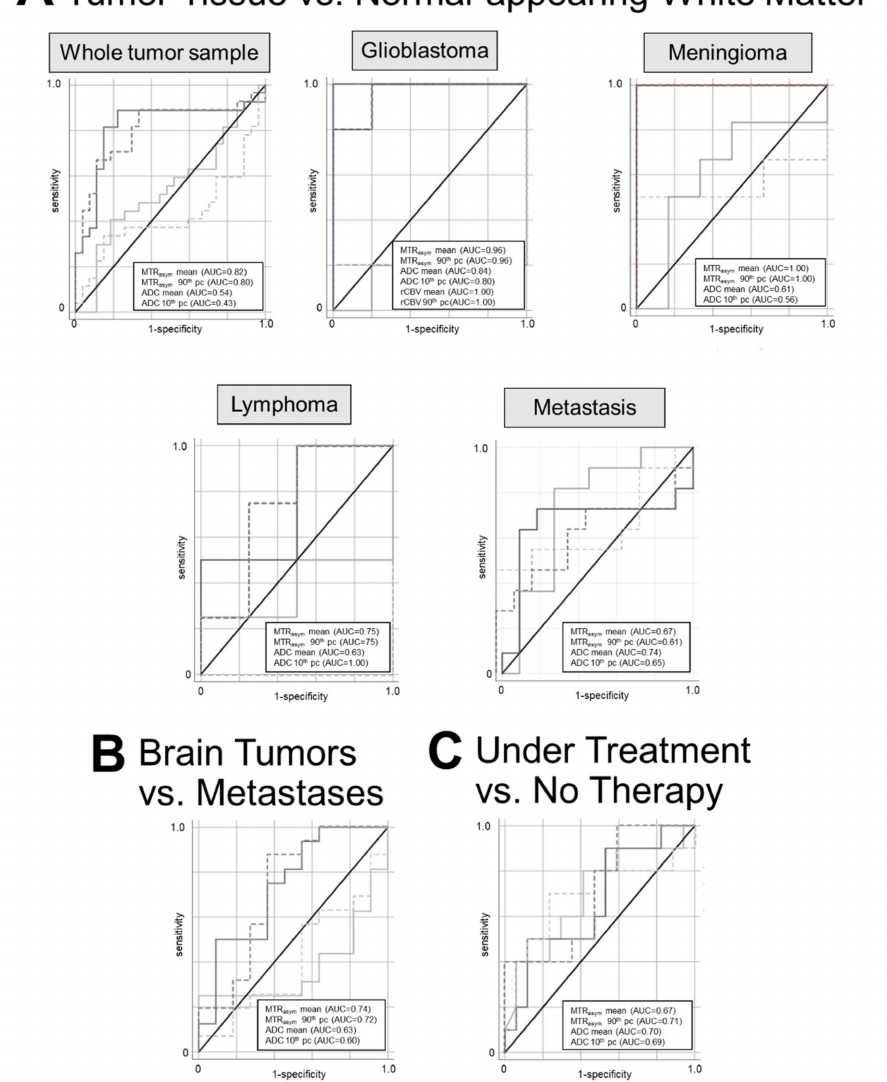
Figure 1. Receiver operating curve characteristics (ROC) curves and area under the curve (AUC) analyses for mean asymmetry magnetization transfer ratio (MTRasym mean: solid dark grey line), 90th percentile MTRasym (MTRasym 90th pc; dashed dark grey line), apparent diffusion coefficient mean (ADC mean; solid light grey line), 10th percentile ADC (ADC 10th pc; dashed light grey line), relative cerebral blood volume mean (rCBV mean; dotted black line), 90th pc rCBV (rCBV 90th pc; dotted grey line). AUC values are displayed in brackets. ( A ) Predictability of tumor tissue vs. normal-appearing white matter in the whole tumor sample and subgroups (glioblastoma multiforme, meningioma, lymphoma, intracerebral metastasis). ( B ) Differentiation between primary brain tumors and metastases. ( C ) Differentiation between patients with and without ongoing oncologic